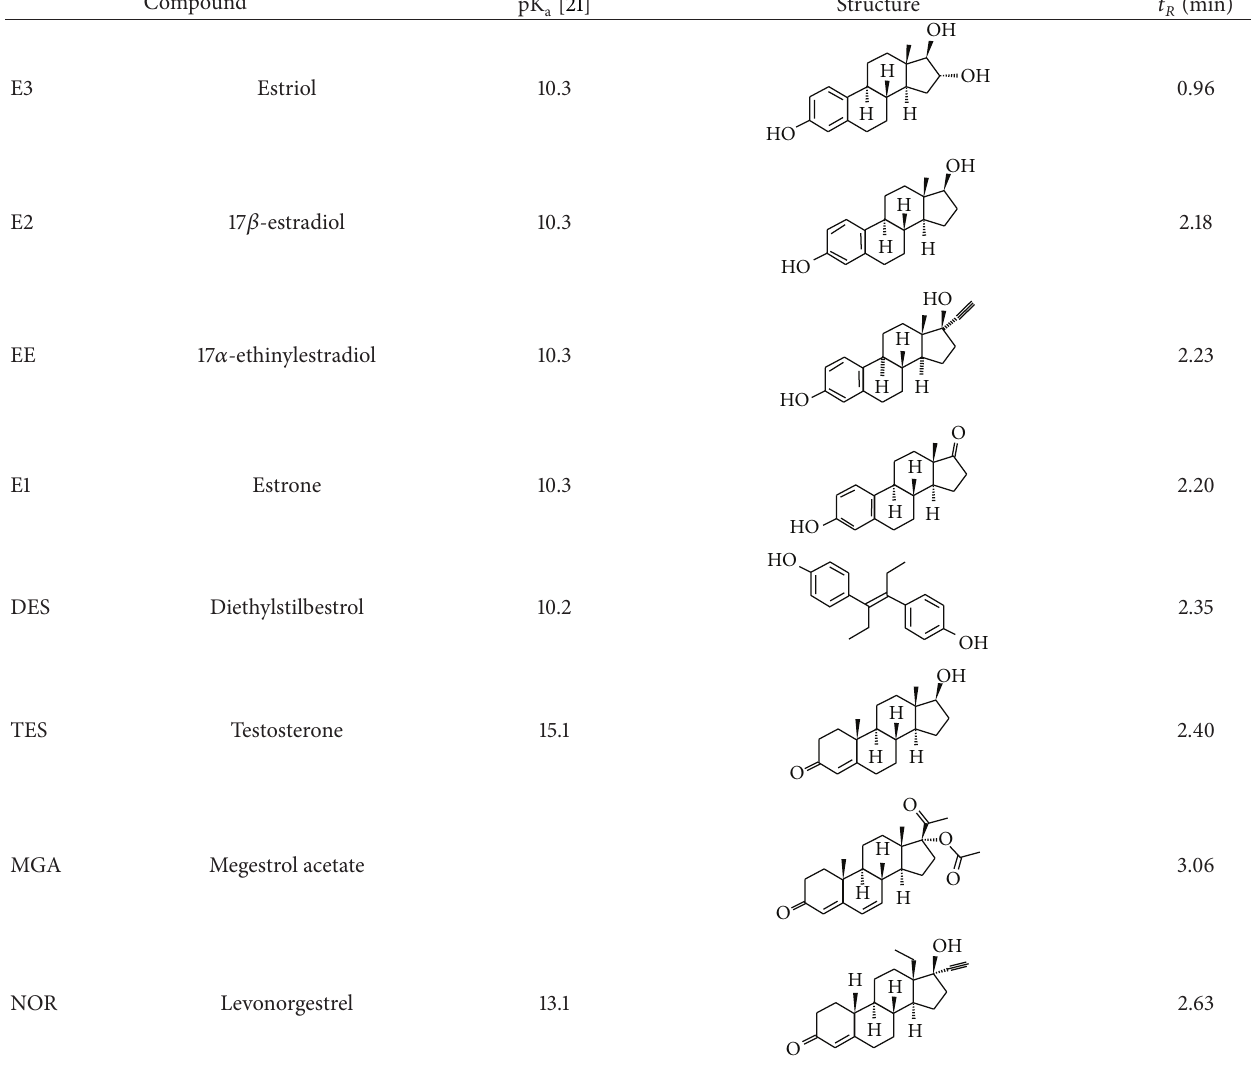
values, chemical structure, and retention times.